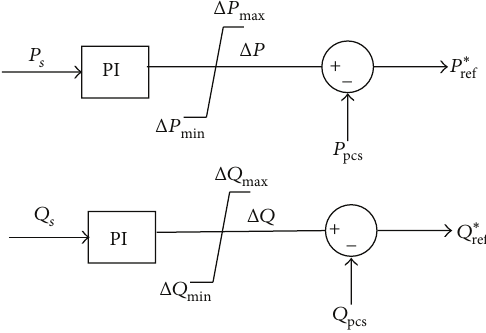
Figure 3: Schematic diagram of the power adjustment.